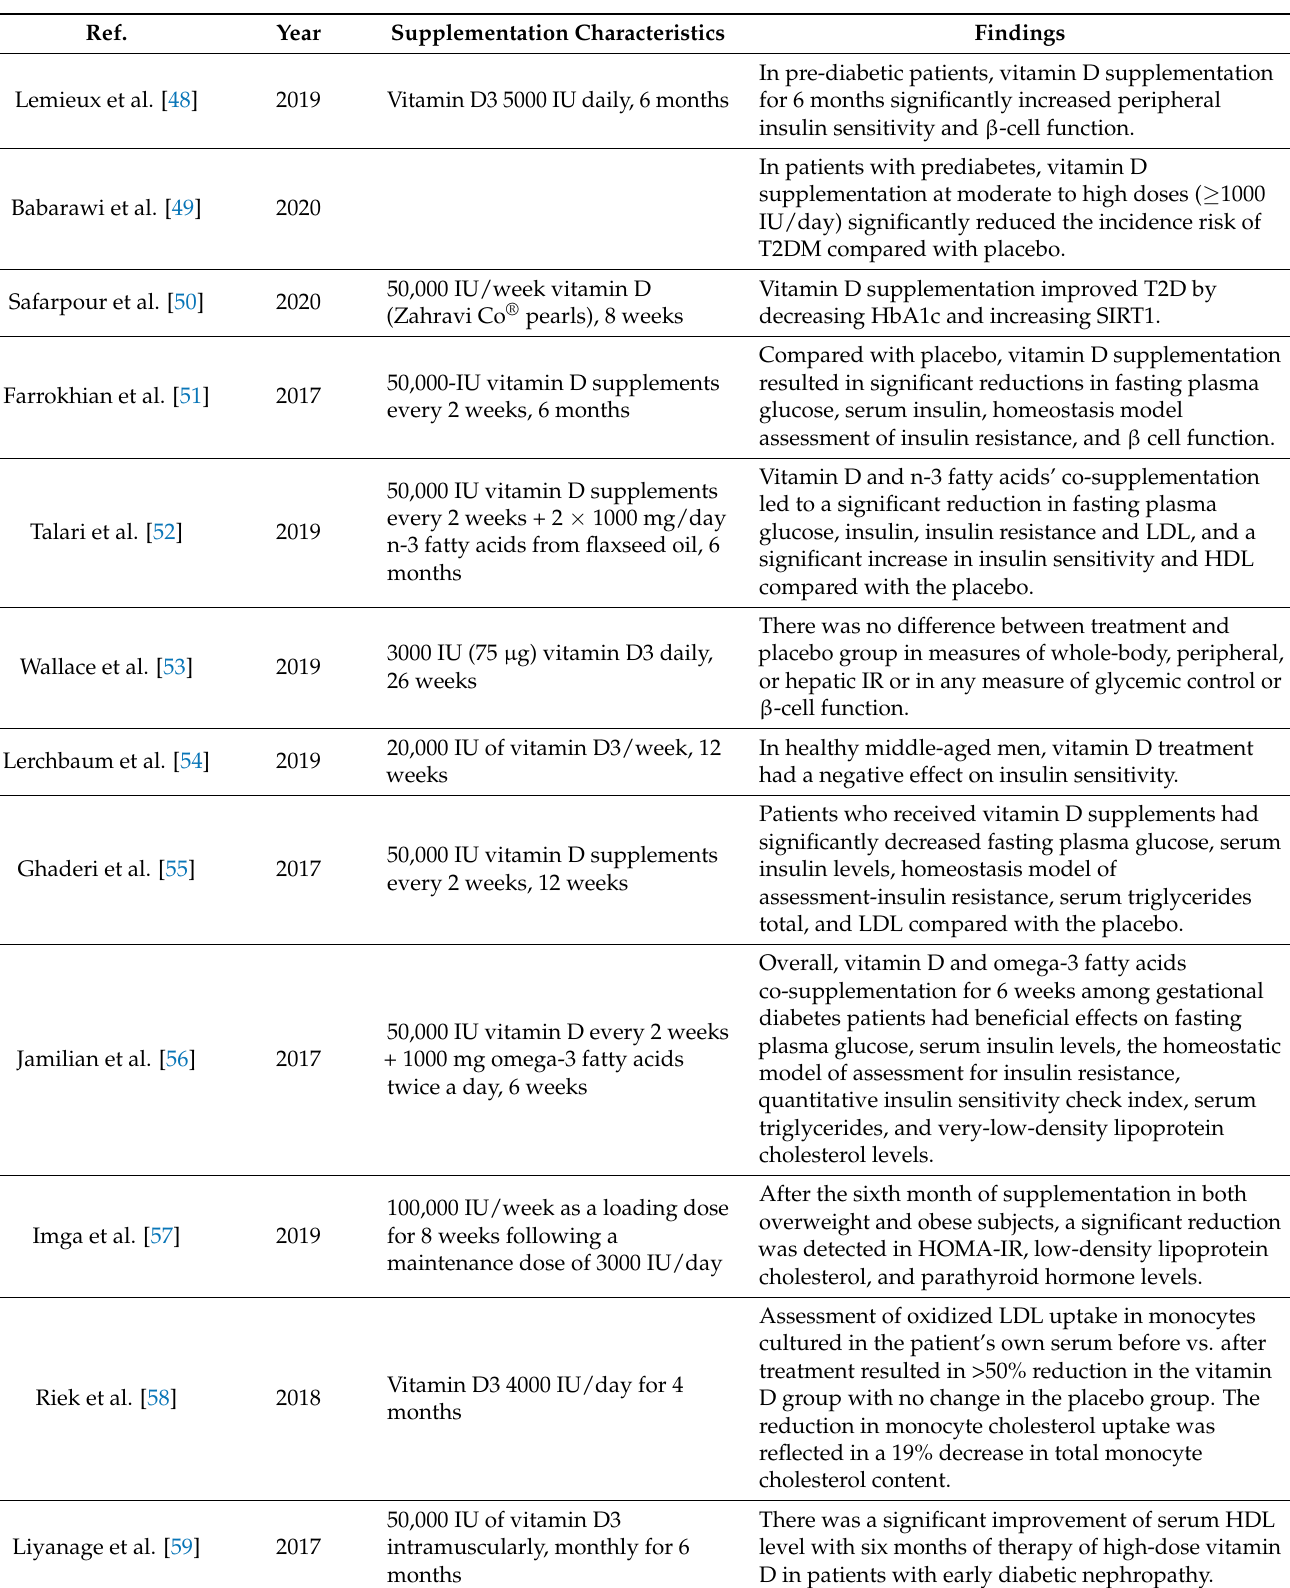
Table 2. Summary of the effects of vitamin D supplementation on metabolic